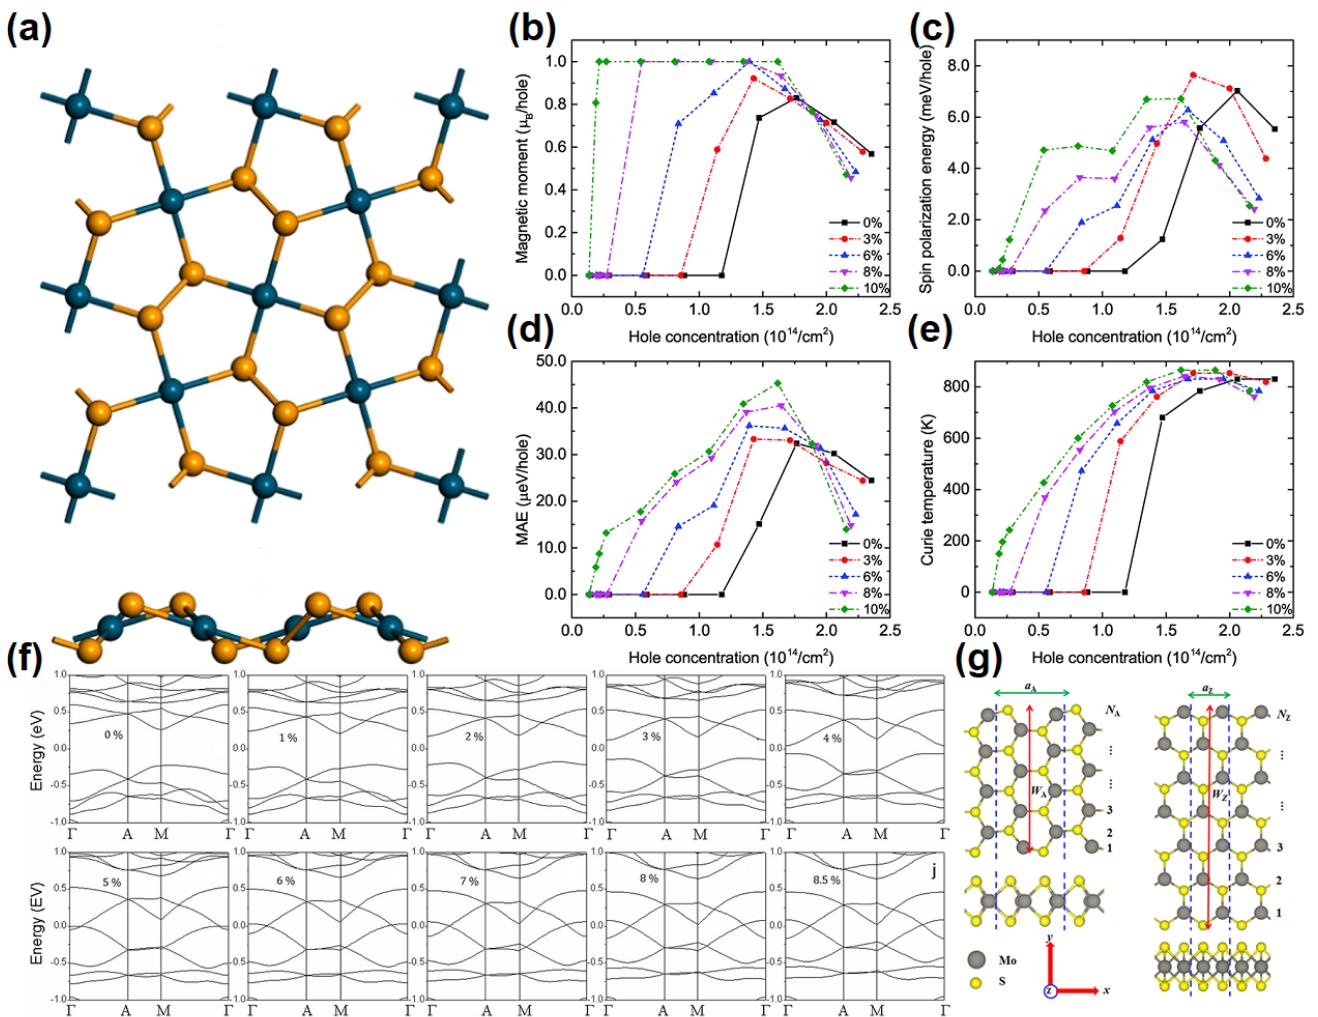
Figure 5. ( a ) The top (upper panel) and side (lower panel) views of PdSe 2 monolayer, respectively. Reused with permission from [127]. ( b – e ) Magnetic moment–spin polarization energy, magnetic anisotropic energy (MAE), and Curie temperature versus hole doping concentration of PdSe 2 under x -axis strains of 0%, 3%, 6%, 8% and 10%. Reused with permission from [128]. ( f ) Calculated band structures of VS 2 -H monolayers under tension ranging from 0 to 18%. Reused with permission from [133]. ( g ) ANRs and ZNRs. The gray (yellow) balls stand for W (S) atoms. The unit cells are depicted by the blue dashed lines. The lattice constants, a A and a Z , of the ANRs and ZNRs are indexed by green arrows, whereas the widths, WA and WZ, of the ANRs and ZNRs are depicted by red arrows, which are also described by N A and N Z , respectively. Reused with permission from [140] .